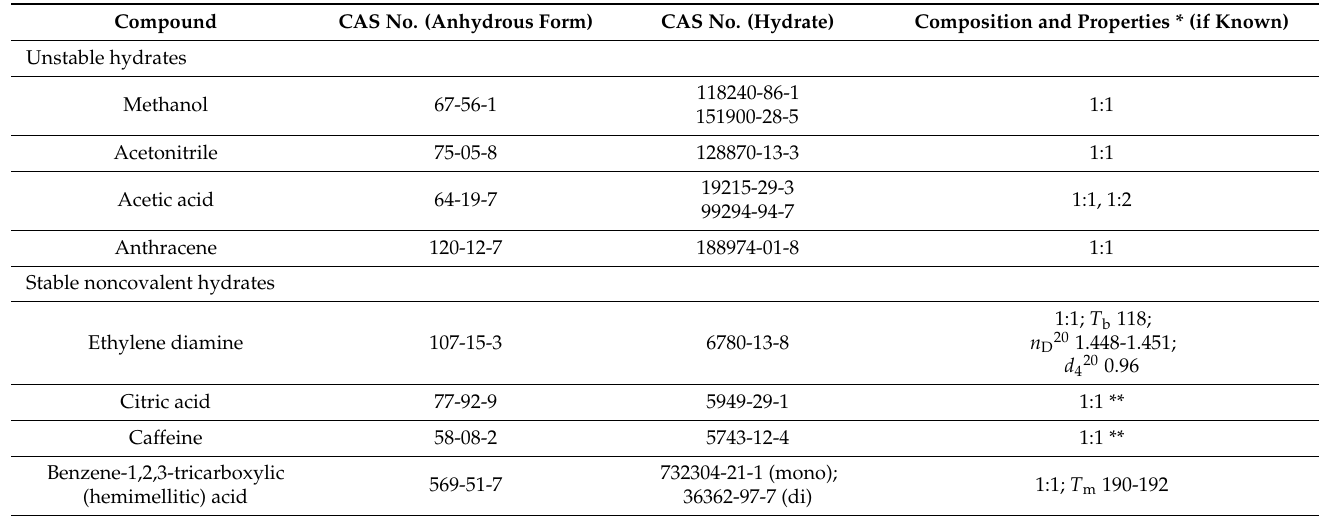
Table 1. Some examples of reference data for hydrates of organic